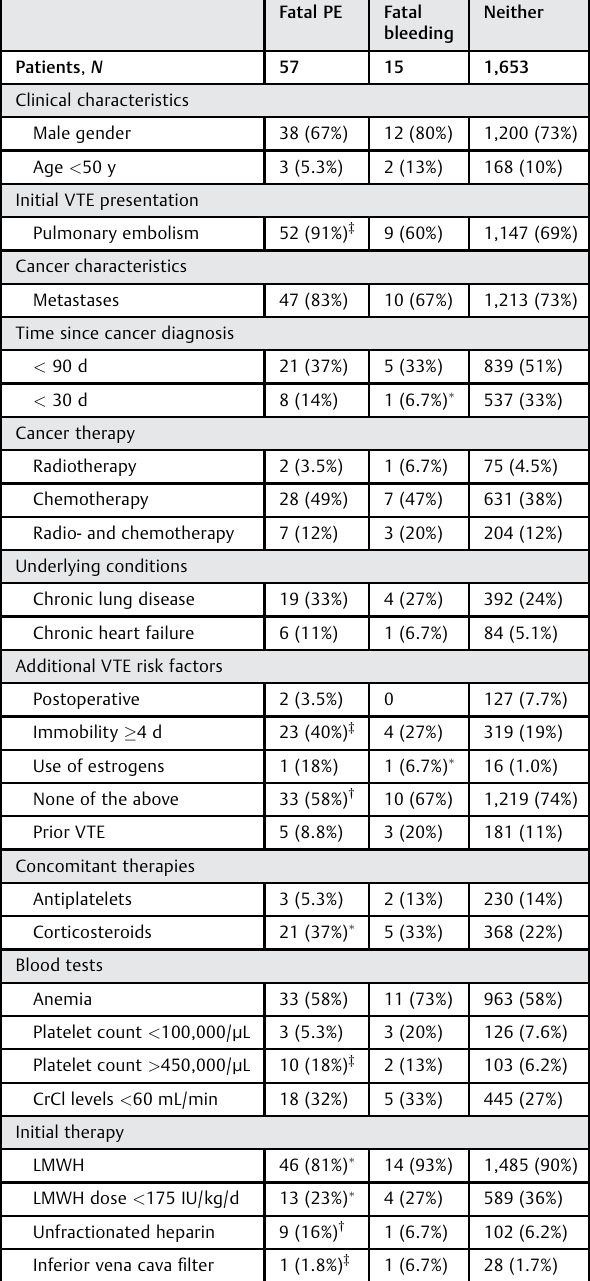
Fatal PE Fatal Neither bleeding